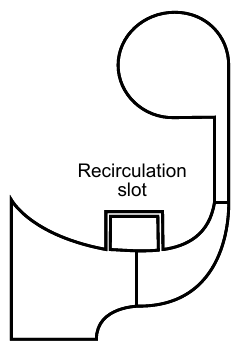
Figure 11. Example of a self-circulating casing treatment in a centrifugal compressor.